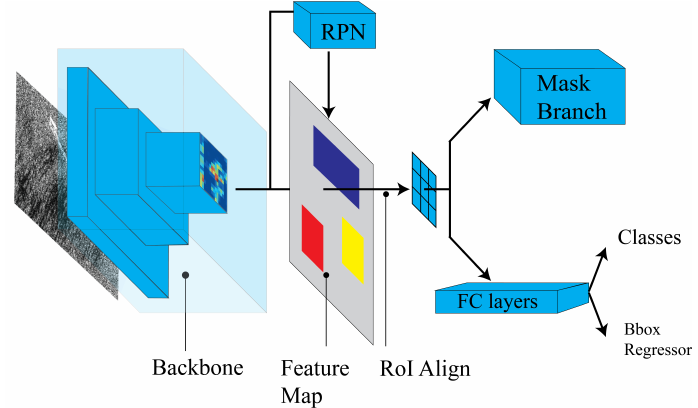
Figure 2. Mask R-CNN architecture